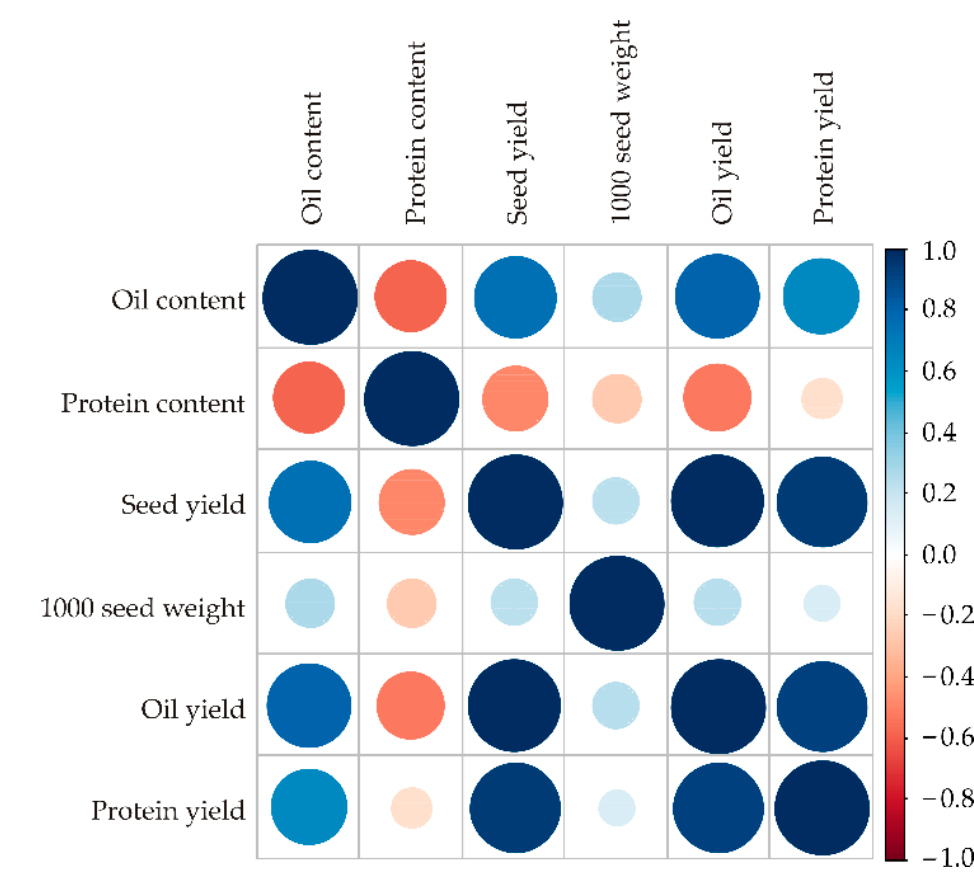
Figure 1. Colour correlation graph between genotypic values for six analysed traits during four-year period. Numerical data represent the coefficients of correlations.